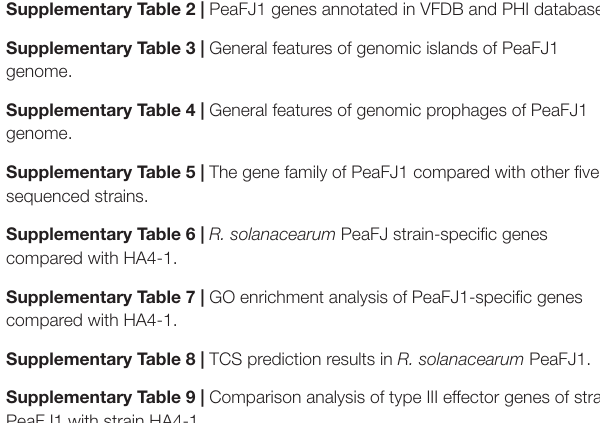
heatmap of ANI percentage identity for PeaFJ1 with other R. solanacearum strains. The number in the heatmap indicates different ANI percentage. Supplementary Figure 3 | Schematic diagram of two-component systems in R. solanacearum PeaFJ1. (A) The 19 TCSs in the chromosome. (B) The 13 TCSs in the megaplasmid. HisKA (blue): Phosphate receptor domain containing an H-box of conserved histidine sites capable of autophosphorylation. HATPase_c (red) is the intracellular catalytic domain of histidine kinase, responsible for the transfer of ATP phosphate groups to histidine. Response_reg (green): Response regulator (RR), response regulator protein. Black module: transmembrane helix. Numbers at both ends: gene ID. Supplementary Table 1 | Basic annotation of PeaFJ1 chromosome and megaplasmid. Supplementary Table 2 | PeaFJ1 genes annotated in VFDB and PHI database. Supplementary Table 3 | General features of genomic islands of PeaFJ1 genome. Supplementary Table 4 | General features of genomic prophages of PeaFJ1 genome. Supplementary Table 5 | The gene family of PeaFJ1 compared with other five sequenced strains.